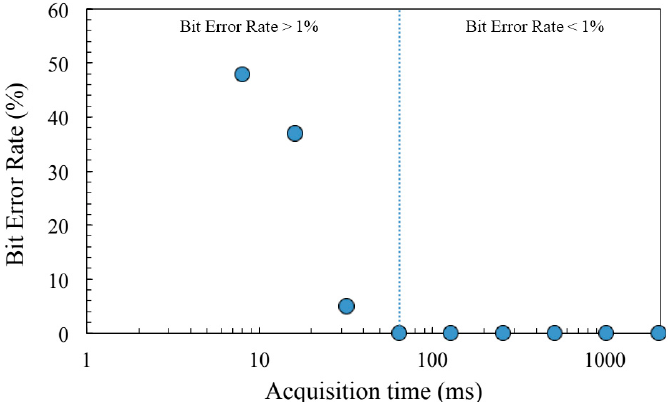
Figure 8. BER (%) calculated by using the 100 signatures of the tag, versus the acquisition duration. As expected, the BER becomes greater when acquisition time decreases.